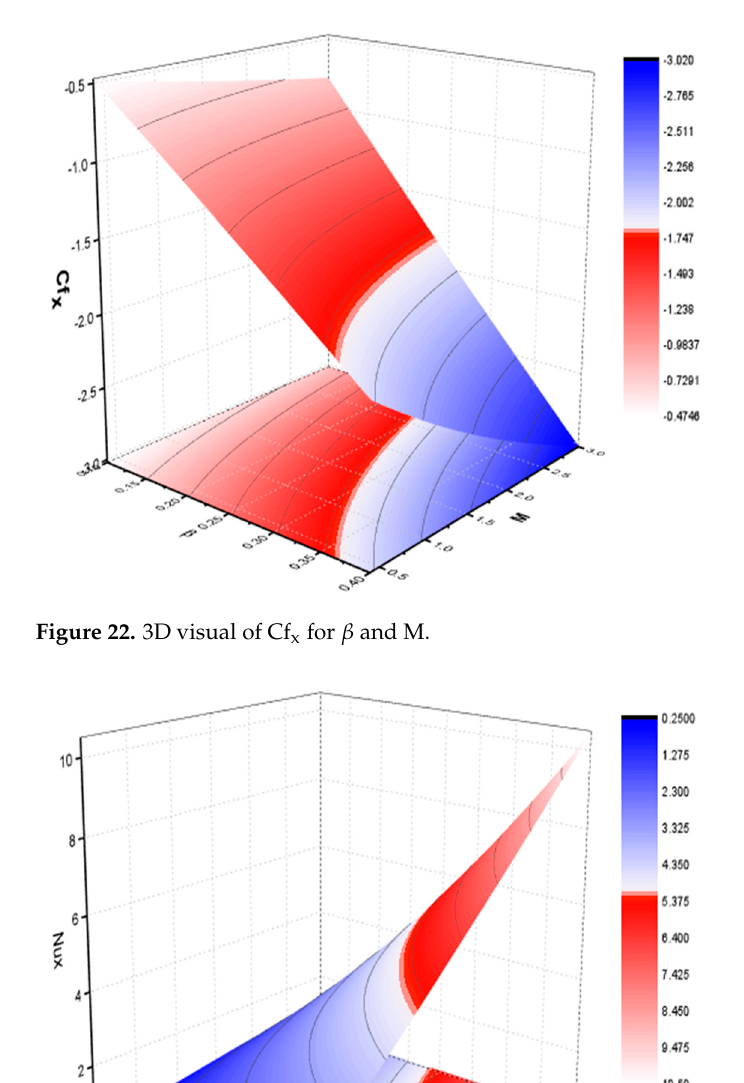
Figure 23. 3D visual of Nu x for Pr and Ec